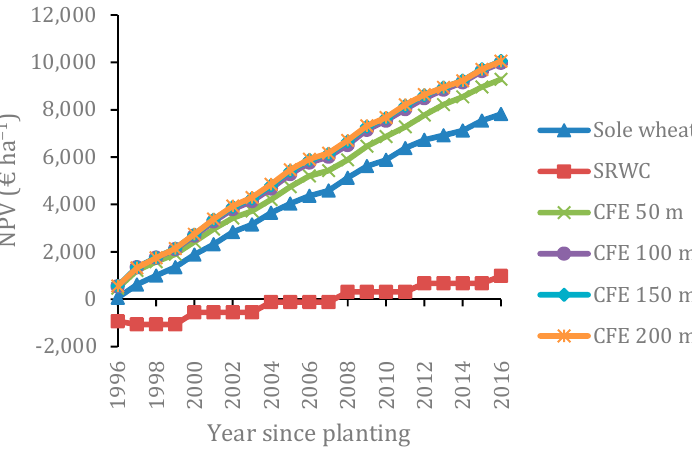
Figure 4. Net present value (NPV) for sole winter wheat, sole short rotation woody crop (SRWC) and four SRWC-winter wheat combined food and energy (CFE) agroforestry scenarios over 21 years.